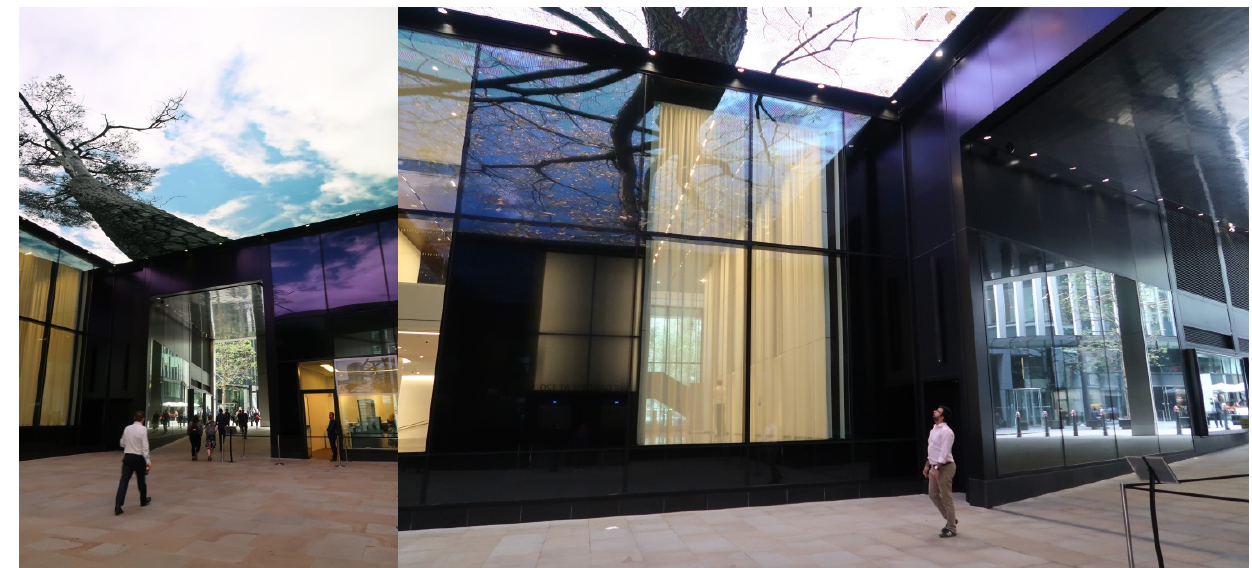
Figure 7. Entrance area on the ground floor of the Fen Court building at 120 Fenchurch Street, London, with a screen suspended from the lobby ceiling. Photo: Anna Jó ź wik, London in 2019.